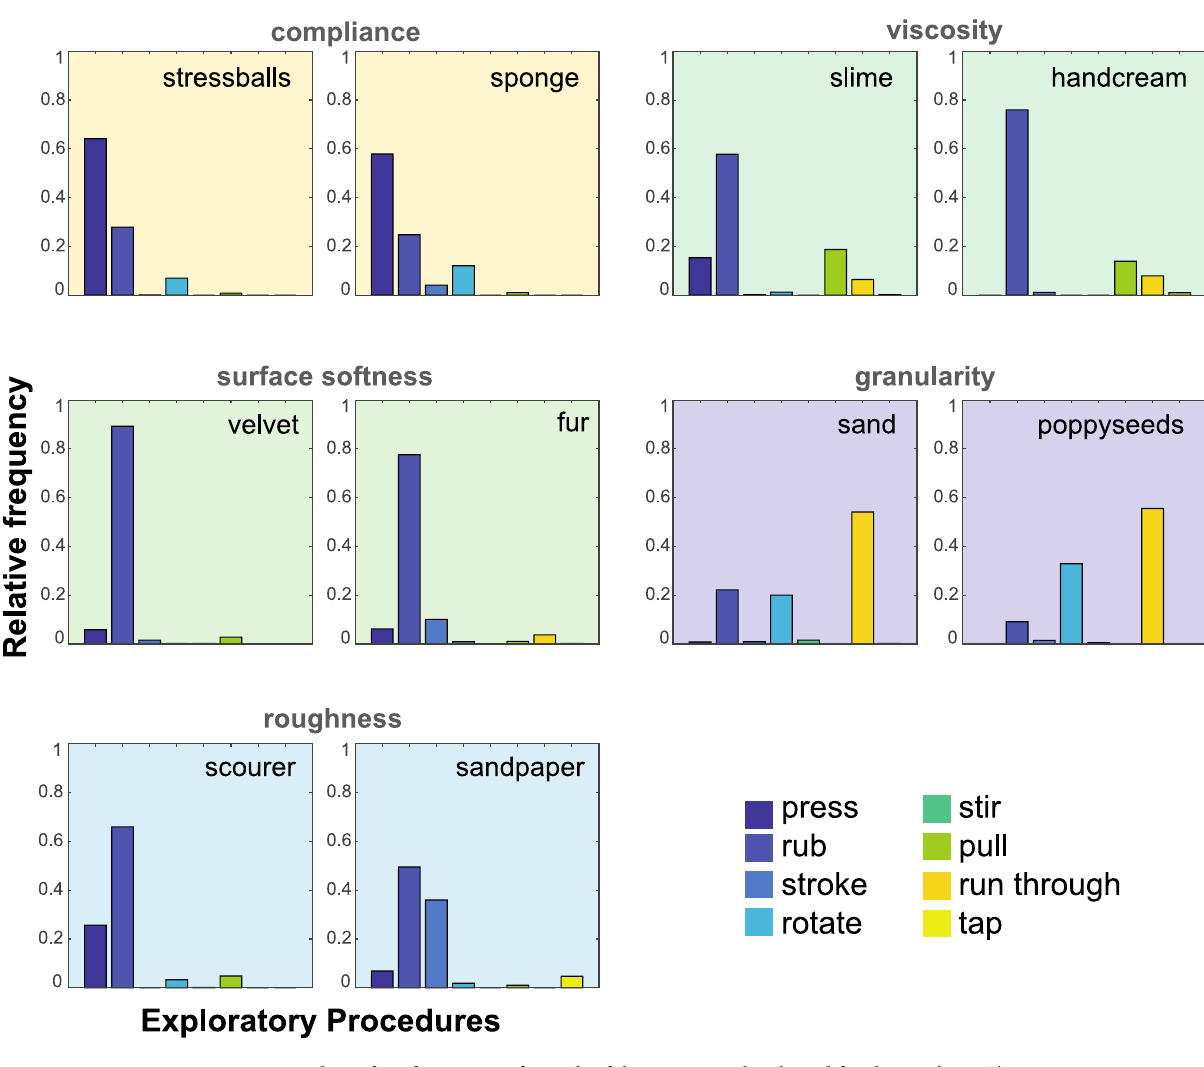
Figure 2. Plots of EP frequencies for each of the 10 materials selected for this analysis. This representation disregards the order of EPs. Each pair of materials is representative of a particular perceptual dimension: four dimensions are related to mechanical properties and one related to